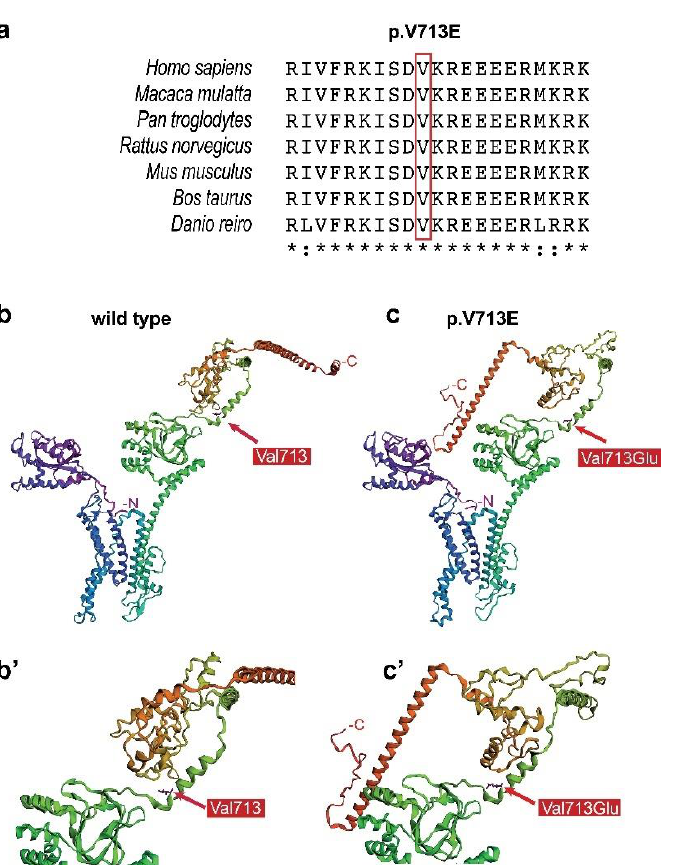
Figure 4. Conservation of the mutated valine among different species ( a ). 3D protein structure prediction of the wild type ( b ), and KCNH1 V713E ( c ), and a zoom in into the mutated residue ( b’ , c’ ). The missense point mutation is predicted to induce a different folding pattern at the C-terminus.